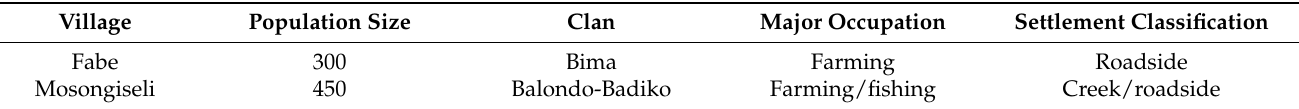
Table 1. Summary of study